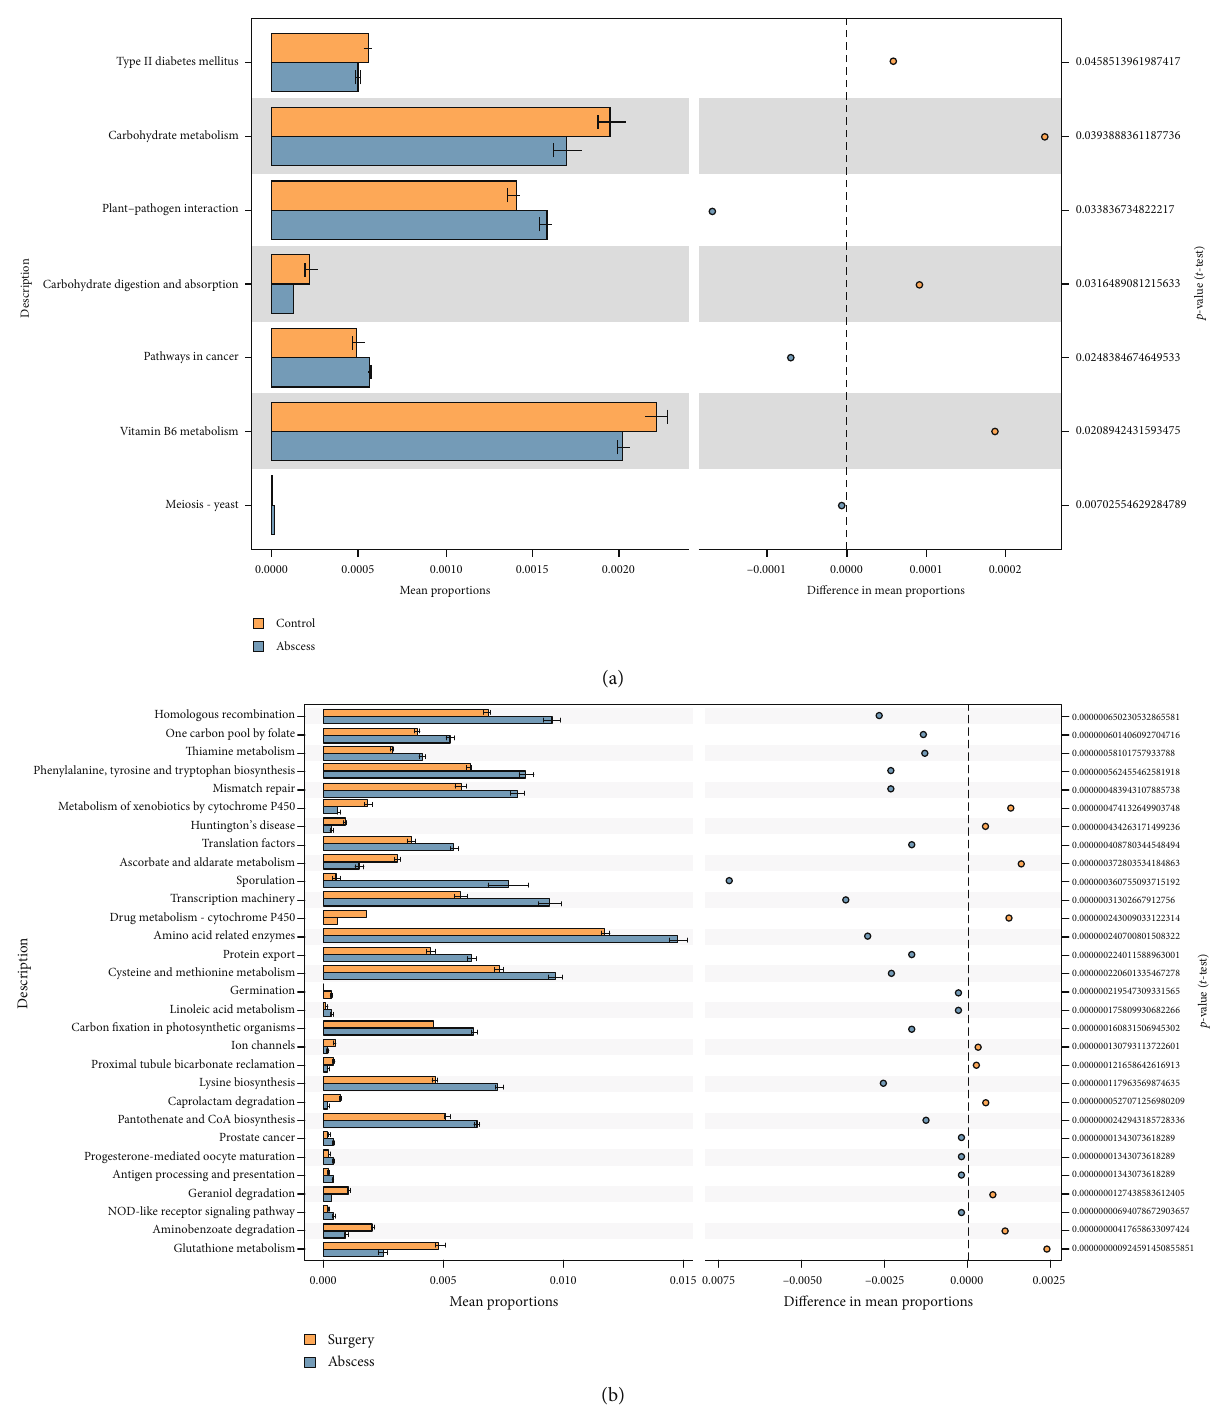
Figure 9: PICRUSt2 functional comparisons between the (a) control and abscess groups and (b) abscess and surgery groups. The t -test was used to generate this fi gure with a threshold value of p < 0 : 05 . The results showed that the KEGG pathways were statistically signi fi cantly di ff erent in the di ff erent groups (95%